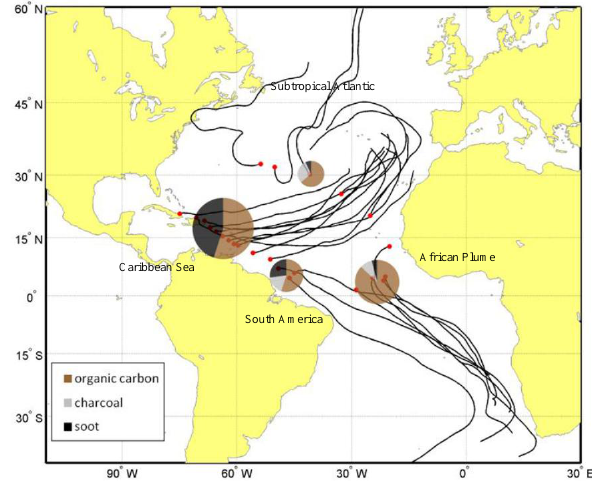
Figure 1. HySPLIT estimates of a 10-day backward wind trajectory at the end of each filter sample at a height of 20m and the average regional fraction of black carbon within the total organic carbon (Mercator projection). Black carbon is further divided between thermally unstable organic carbon, soot (CTO-375), and charcoal (pyrene fluorescence loss). The size of each pie chart is in accordance to regional average total organic carbon concentration rang- ing from 0.2 to 1.8µgm − 3